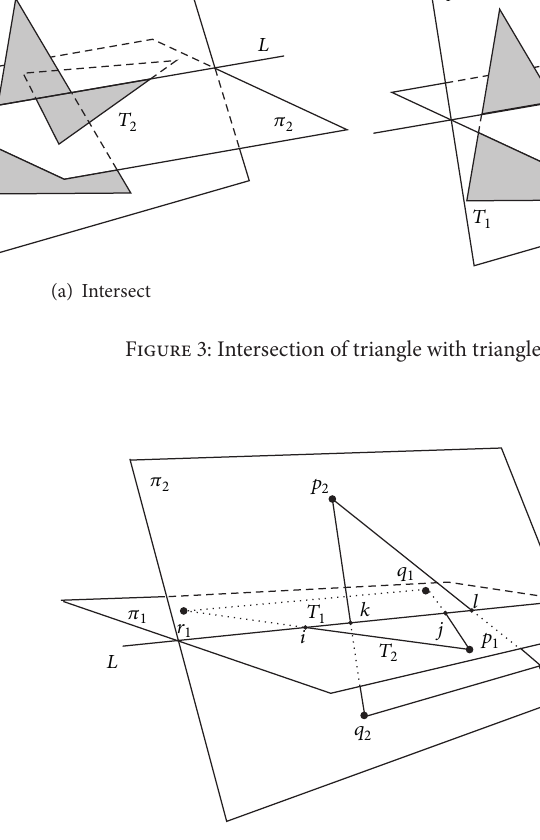
Figure 4: Computing the intersection of triangle-triangle with Devillers algorithm [98, 99].